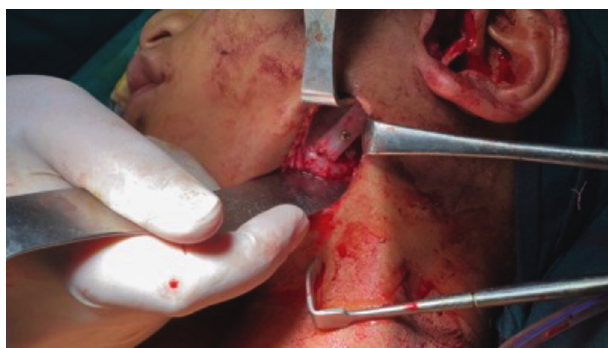
Figure 11: The graft is secured to the lateral side of the ramus.